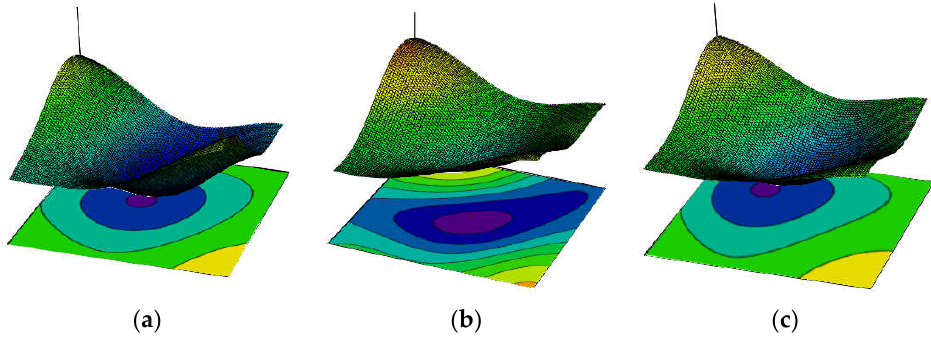
Figure 2. Exemplary profiles of cross-correlated and spatially auto-correlated random distributions of local material parameters: ( a ) f t , ( b ) G f and ( c ) E mod .